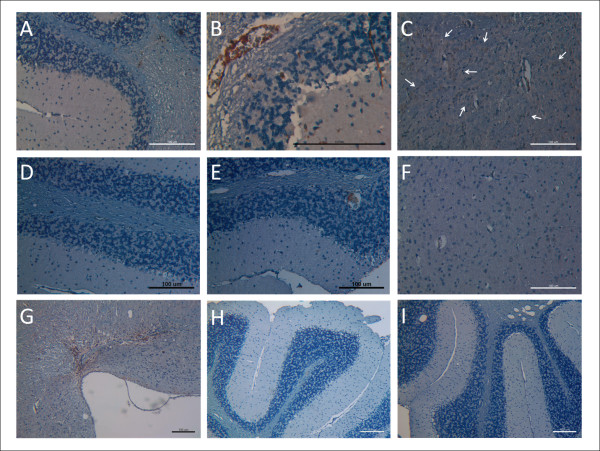
Immunohistochemistry staining for human mesenchymal stem cells in whole brain sections of mice. Whole brain sections of each mice (4 μm) were proceeded immunohistochemistry staining of β2 microglobulin for hMSCs. Photographs were taken from the view of 100, 200 or 400-folds microscopy and the scale bar was 100 μm. (A-C) In IV-hMSC-Tg group, hMSCs were located over the cerebellar white matter (A), molecular layer, and the lumens of blood vessels in white matter (B). Large clusters of grafted hMSCs were detected within cerebral cortex as arrows (C). (D-G) In IC-hMSC-Tg group, positive brown signals were not detected over cerebellar white matter, molecular layer, or the Purkinje cell layer (D), but limited to a few lumen of blood vessels (E) and a few scattered cells in cerebral cortex (F). Positive signals of hMSCs were detected over the injection site beneath the dorsal surface of medulla (G), which was adjacent to the cerebellum. (H, I) No signals were detected in the cerebellar sections of Control-Wt (H) and Control-Tg mice (I).